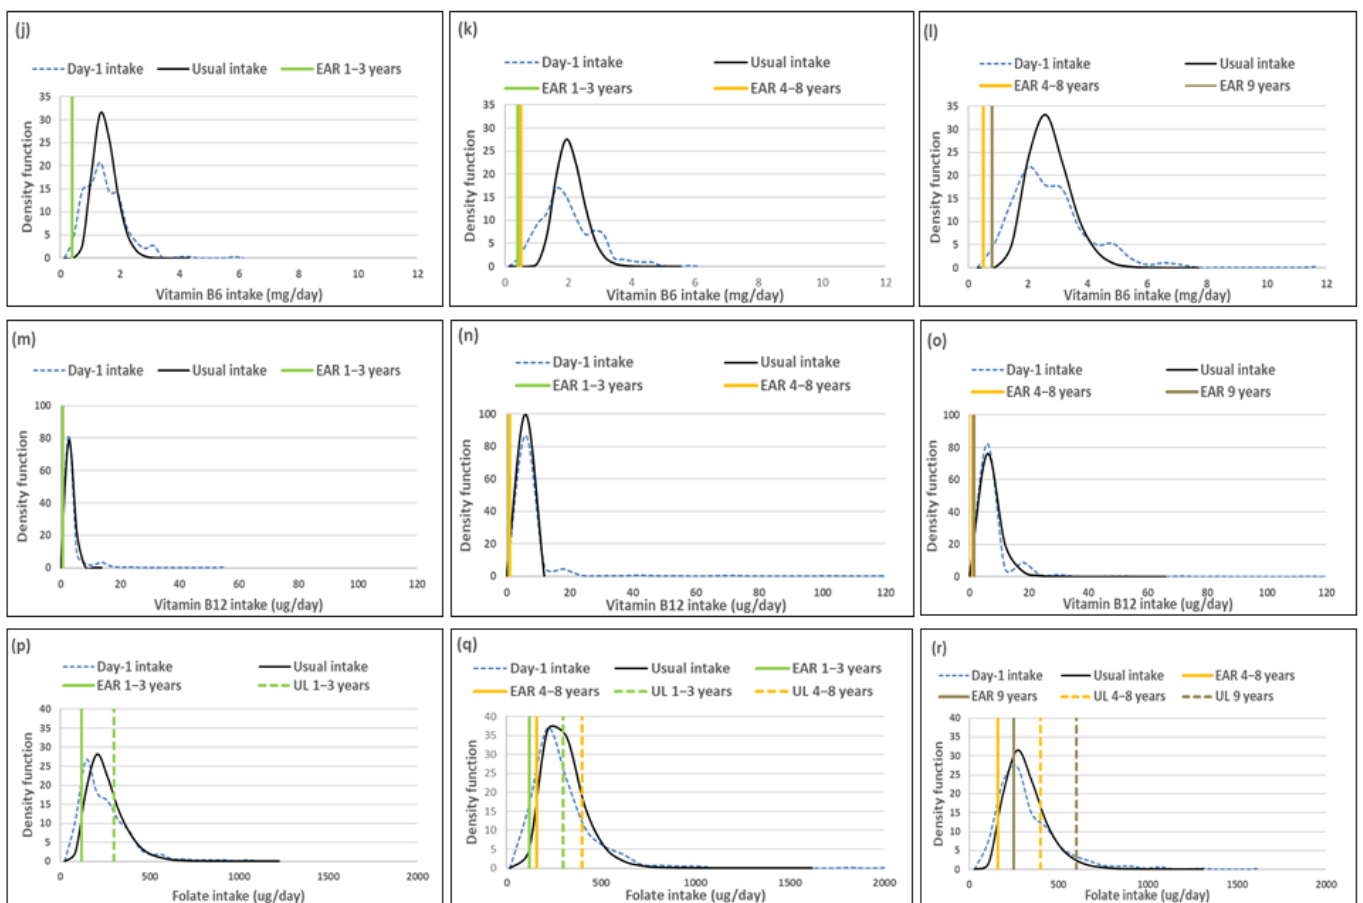
Figure 3. Distributions of the simulated, back-transformed values (usual intake) and the distribution of Day-1 intakes within the context of DRI-values of thiamin, niacin, riboflavin, vitamin B6, vitamin B12 and folate, by age group. ( a ): Age 1–<3 years: Thiamin intake; ( b ): Age 3–<6 years: Thiamin intake; ( c ): Age 6–<10 years: Thiamin intake; ( d ): Age 1–<3 years: Niacin intake; ( e ): Age 3–<6 years: Niacin intake; ( f ): Age 6–<10 years: Niacin intake; ( g ): Age 1–<3 years: Riboflavin intake; ( h ): Age 3–<6 years: Riboflavin intake; ( i ): Age 6–<10 years: Riboflavin intake; ( j ): Age 1–<3 years: Vitamin B6 intake; ( k ): Age 3–<6 years: Vitamin B6 intake; ( l ): Age 6–<10 years: Vitamin B6 intake; ( m ): Age 1–<3 years: Vitamin B12 intake; ( n ): Age 3–<6 years: Vitamin B12 intake; ( o ): Age 6–<10 years: Vitamin B12 intake; ( p ): Age 1–<3 years: Folate intake; ( q ): Age 3–<6 years: Folate intake; ( r ): Age 6–<10 years: Folate